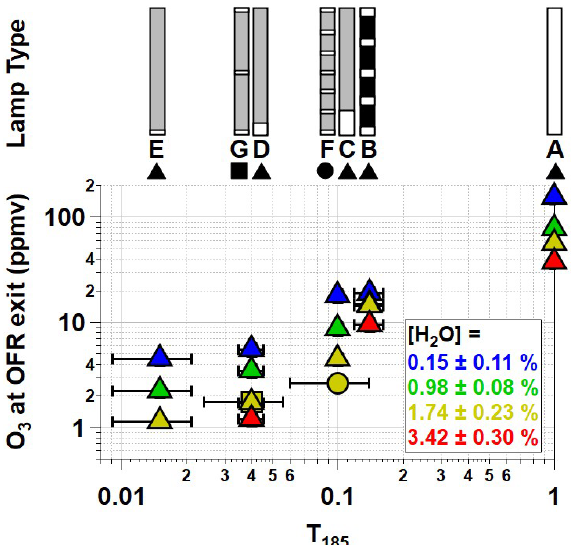
Figure 2. O 3 mixing ratio generated using OFR185 at I 254 = ( 3 . 5 ± 0 . 7 ) × 10 15 photonscm − 2 s − 1 (lamp types A and C–G) and I 254 = 5 . 8 × 10 14 photonscm − 2 s − 1 (lamp type B) as a function of T 185 and [H 2 O]. Error bars represent ± 1 σ of replicate O 3 measure- ments and ± 2mm uncertainty in lengths of individual T 185 = 0 and 1 segments.